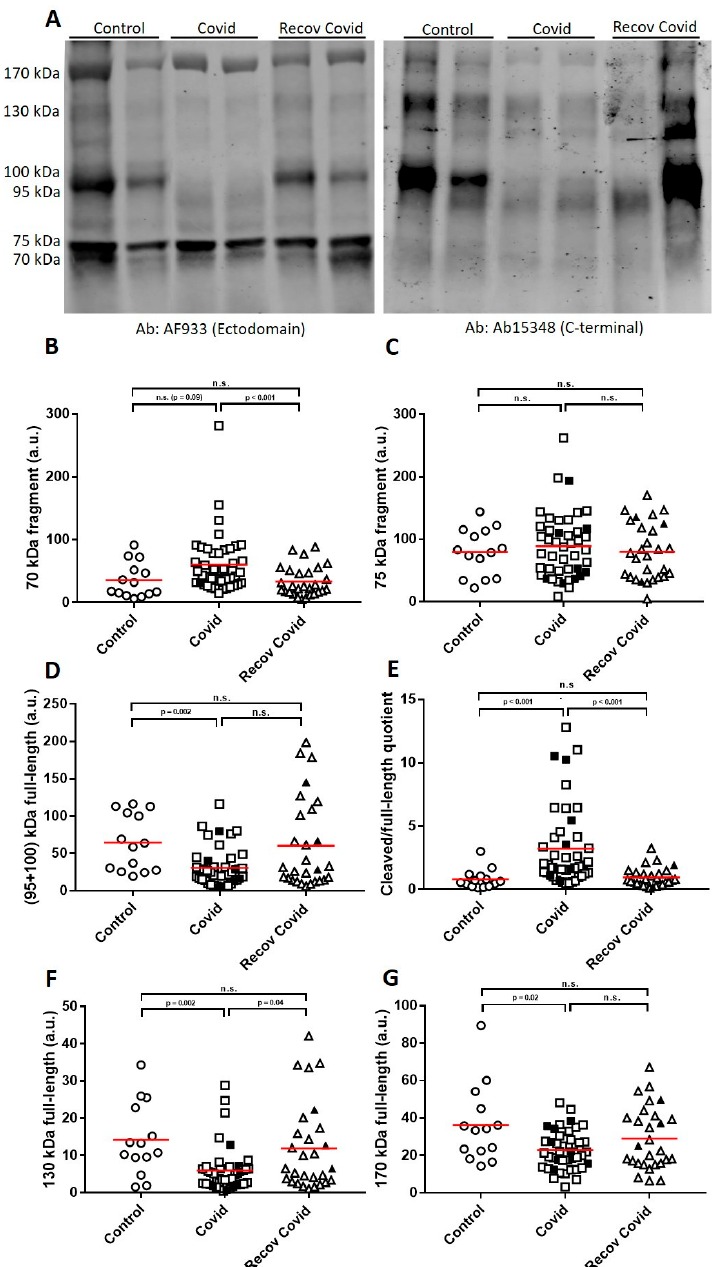
Figure 3. Densitometric quantifications for circulating ACE2 species in COVID-19 patients. ( A ) Rep- resentative western blots of control cases, COVID-19 patients at acute phase of the disease (Covid) and at recovery (interval of ~2 month between hospital admission and recovery) were resolved, as indicated, with the AF933 (left image) that recognizes the ectodomain of ACE2, thus recognized all ACE2 species, and ab15348 (right image) raised against the C-terminus of human ACE2, thus detecting only full-length species and not C-terminal truncated fragments. Densitometric quantifica- tion of the ( B ) 70 kDa fragment, ( C ) 75 kDa fragment, ( D ) sum of 95 + 100 kDa full-length species, ( E ) the ACE2 cleaved (70 kDa)/full-length (95 + 100 kDa) quotient obtained by dividing the level of immunoreactivity of the 70 kDa fragment by the sum of the levels of immunoreactivity of the 95 and 100 kDa full-length form. Densitometric quantification of the ( F ) 130 kDa full-length species and ( G ) 170 kDa full-length species of ACE2 are shown. Circles: Controls; squares: Covid; triangles: recov Covid; white symbol: moderate severity; black symbol: severe cases. The values are represented as mean. p values estimated by Mann–Whitney U test are